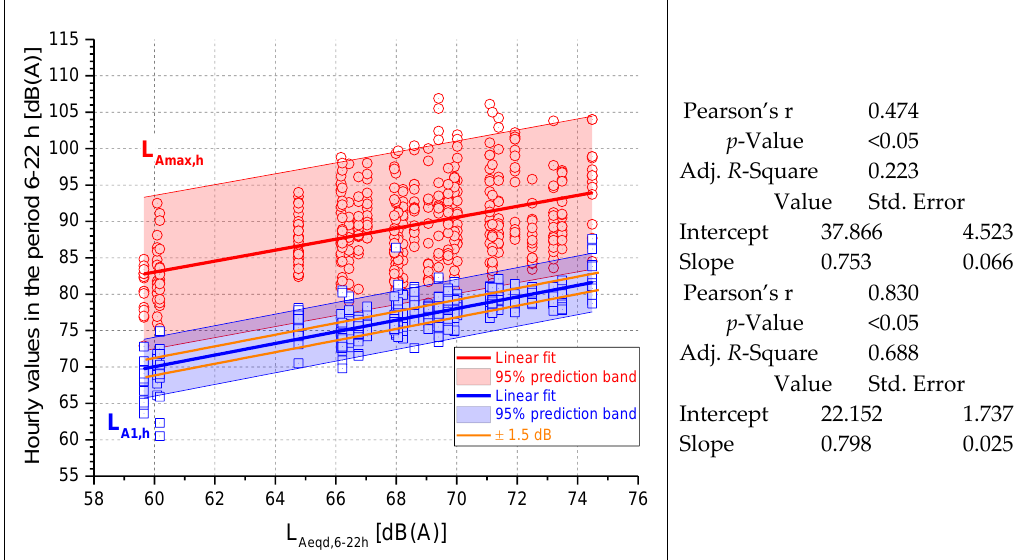
Figure 7. Linear regressions between hourly values in the interval 6 – 22 h of both L Amax and L A1 versus L Aeq, 6 – 22 h for all the streets.